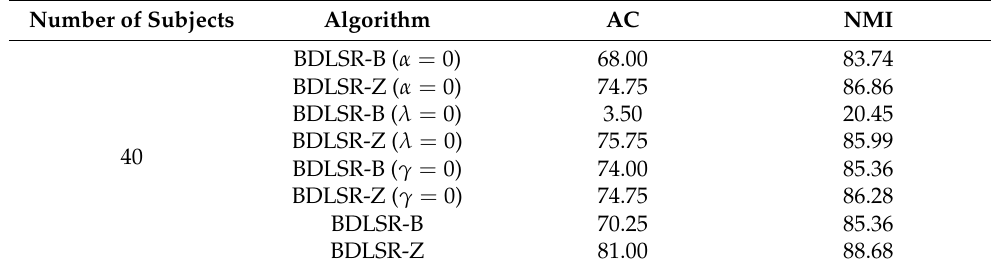
Table 8. A comparison of the results from the different algorithms when using the ORL dataset (%).